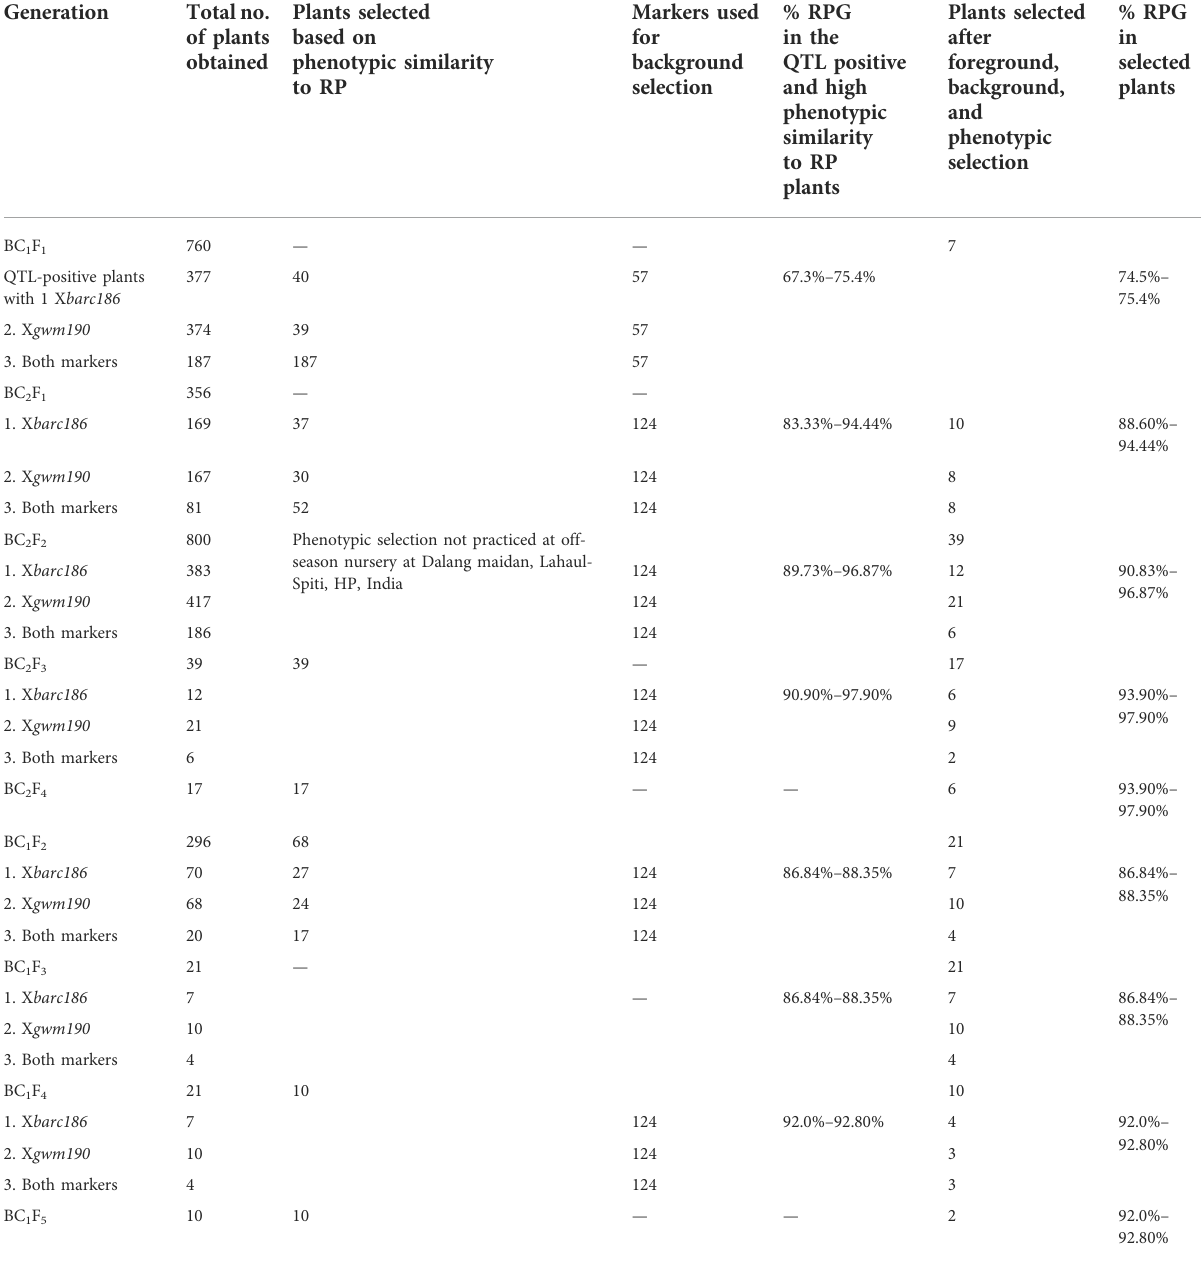
TABLE 2 Number of plants selected and the recurrent parent genome recovery obtained in each of the backcross generations.